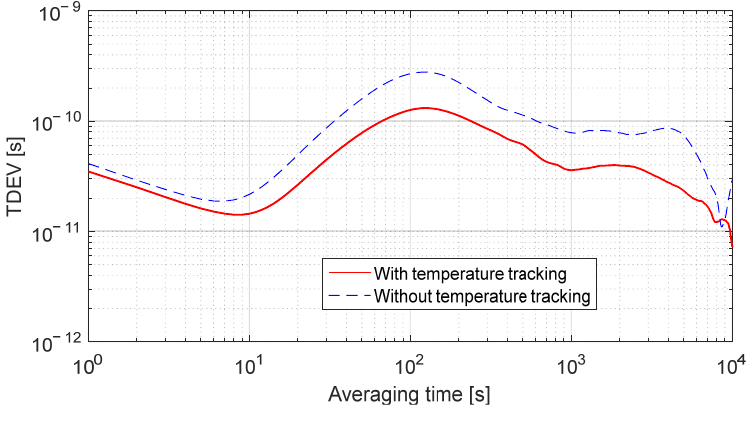
Figure 10. TDEV of two schemes.